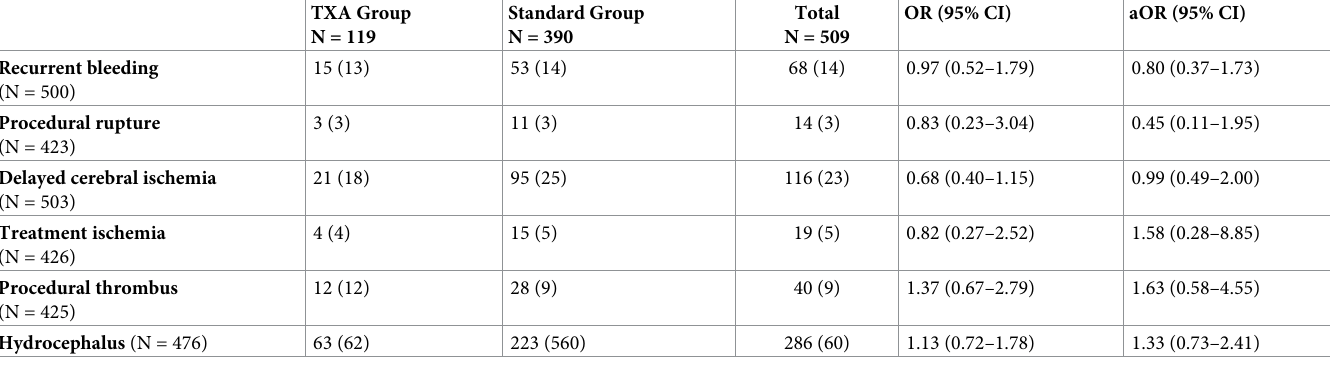
Table 2. Complications per treatment group and adjusted per center with or without TXA